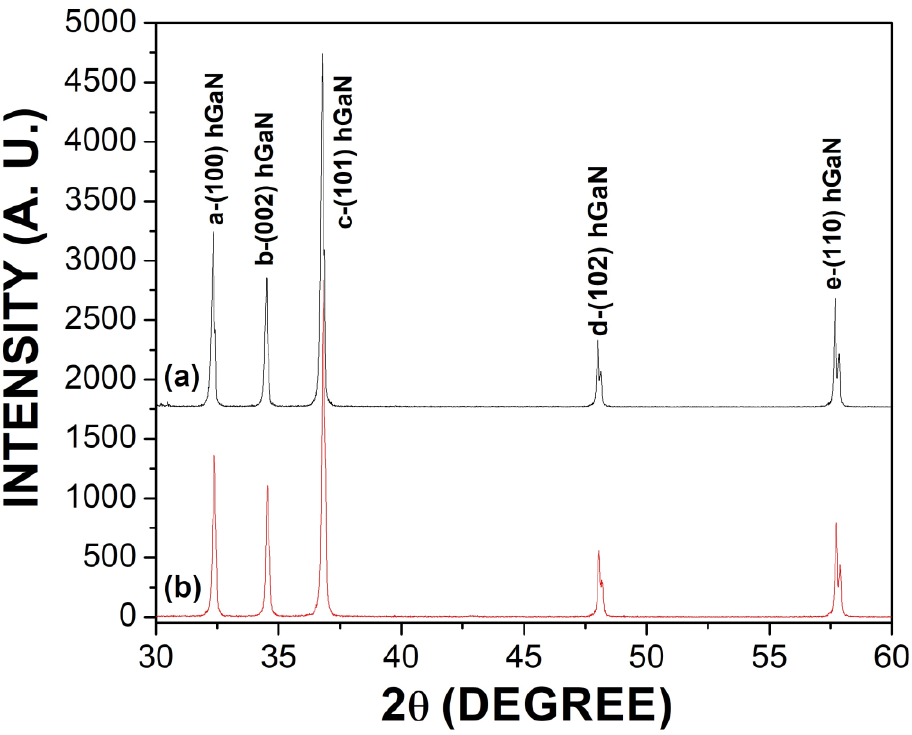
Figure 2. ( a ) XRD pattern of the undoped GaN powders; ( b ) XRD pattern of the Mg-Zn co-doped GaN powders.